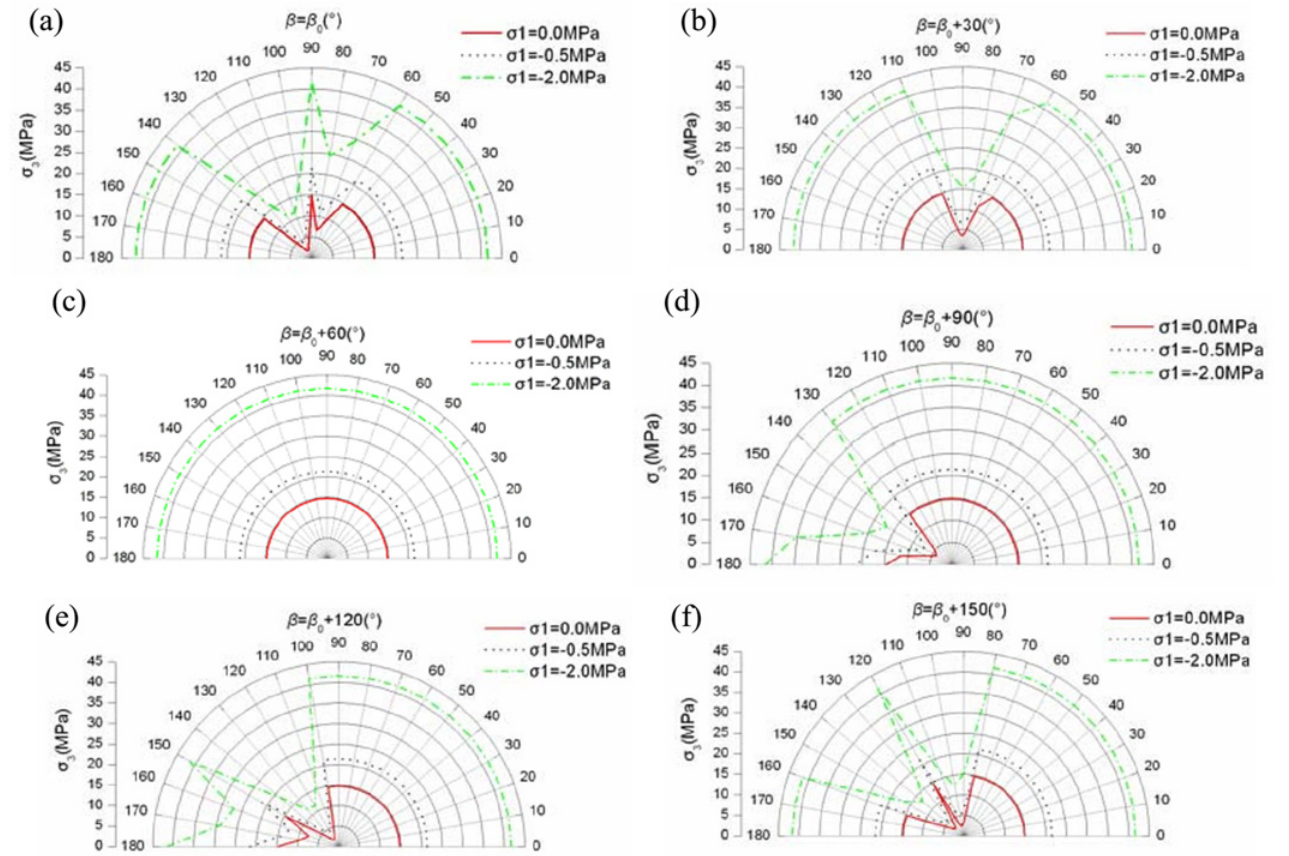
Fig 8. The strength of σ 3 when the relation of β 0 and β is given((a) The strength of σ 3 when β = β 0 ; (b) The strength of σ 3 when β = β 0 +30°; (c) The strength of σ 3 when β = β 0 +60°; (d) The strength of σ 3 when β = β 0 +90°; (e) The strength of σ 3 when β = β 0 +120°; (f) The strength of σ 3 when β =